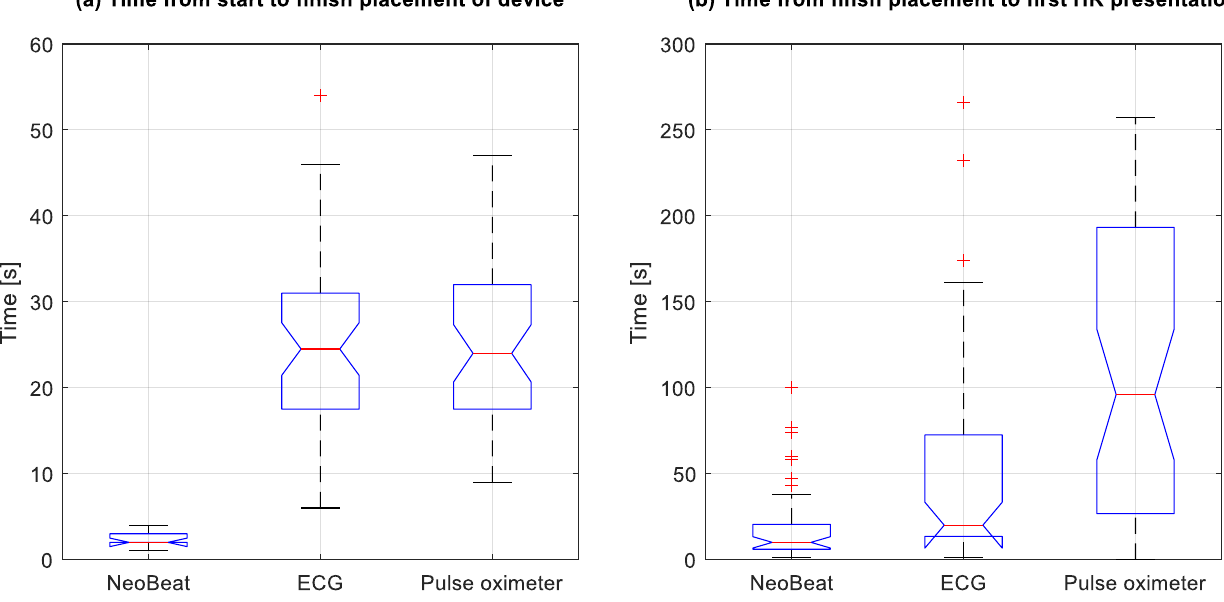
Figure 2. Box plots with comparison of time ( a ) from start to finish placement and ( b ) from finish placement to first HR presentation. Four of 48 cases did not apply Pulse Oximetry before after PPV was discontinued. HR, heart rate. ECG, electrocardiogram. + represents outliers. Note for ( b ): One pulse oximeter outlier at 768 s is not shown.